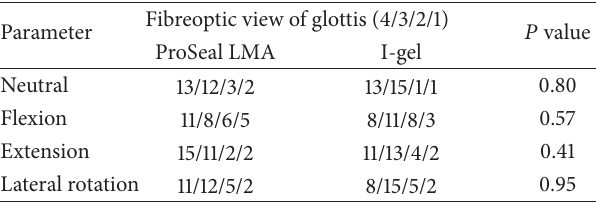
Table 7: Fibreoptic position between the